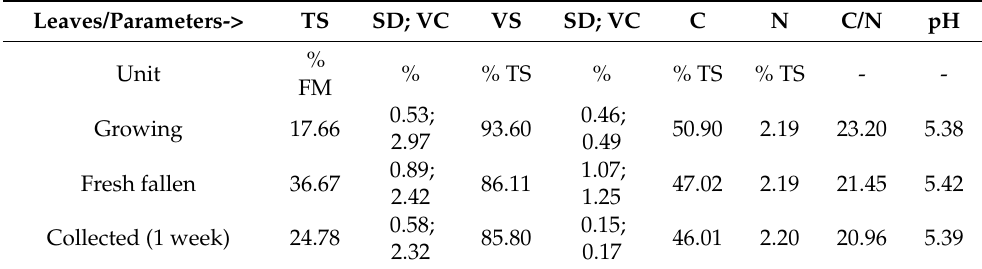
SD—standard deviations VC—variation coefficient.